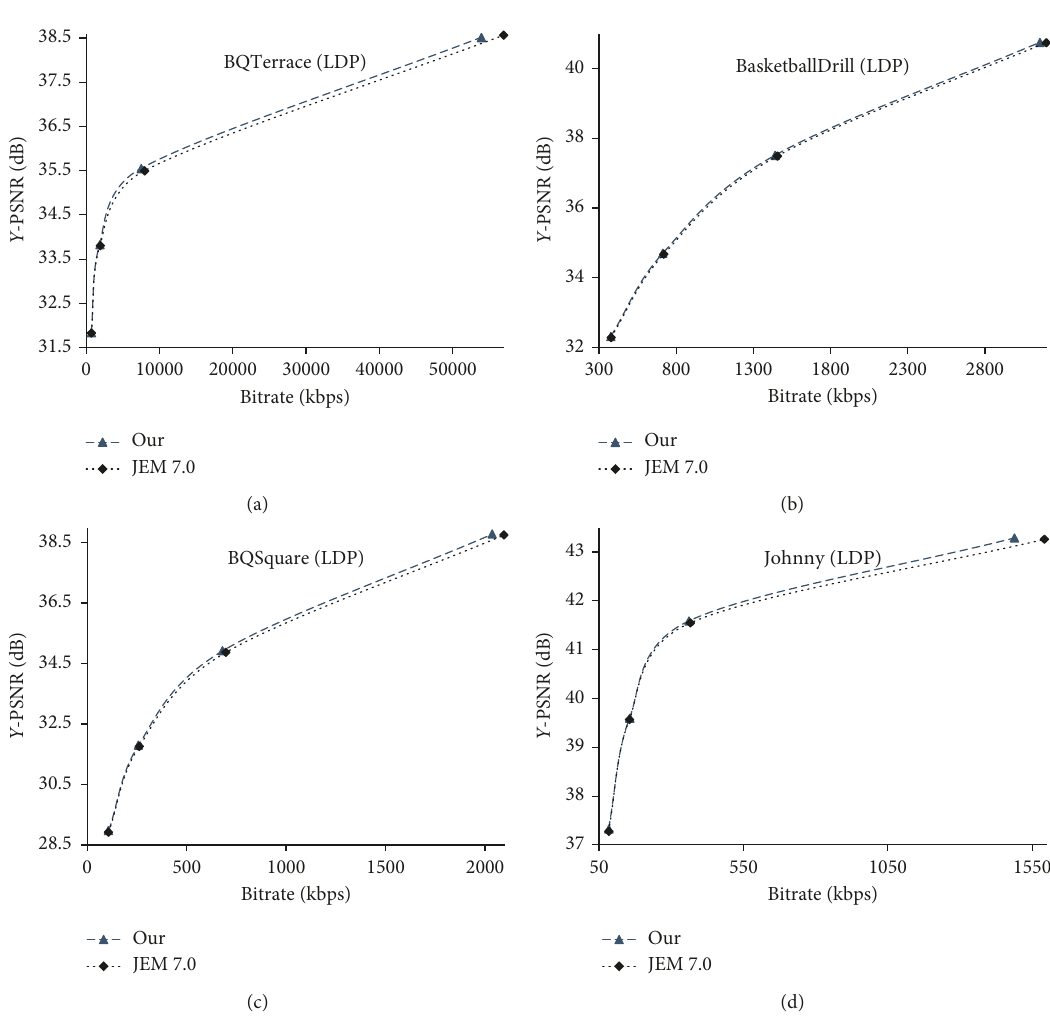
Figure 5: R - D curves comparison under LDP